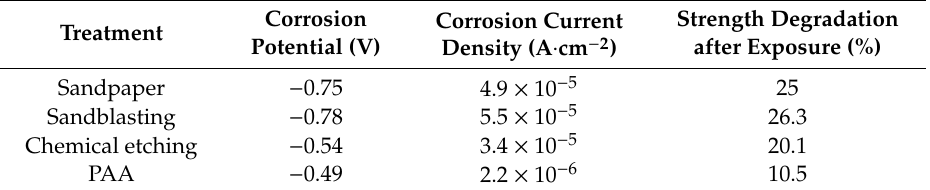
phosphoric acid anodization (PAA) on substrates of different roughnesses. Table 5. E ff ect of surface treatments on corrosion resistant and durability.